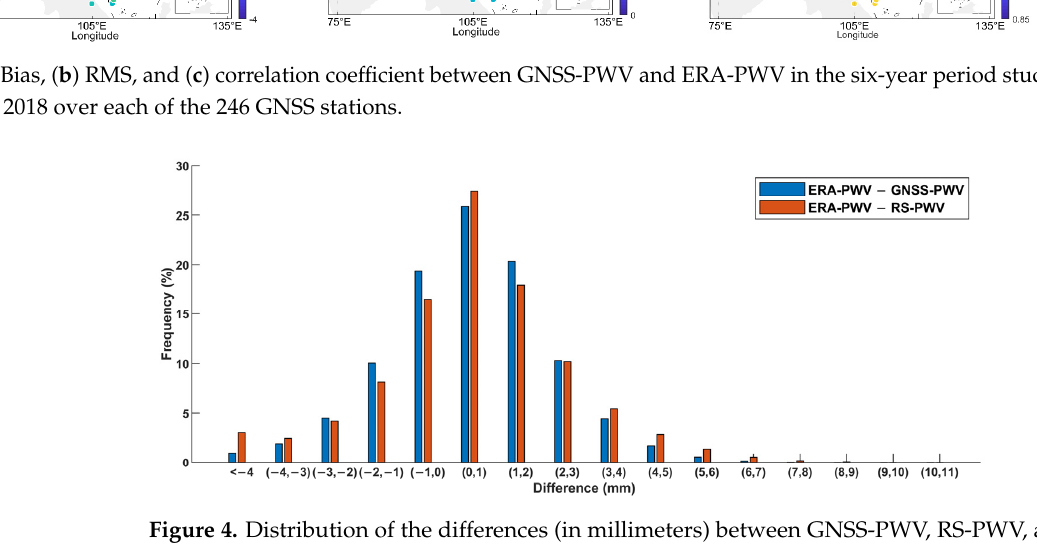
Figure 4. Distribution of the differences (in millimeters) between GNSS-PWV, RS-PWV, and ERA-